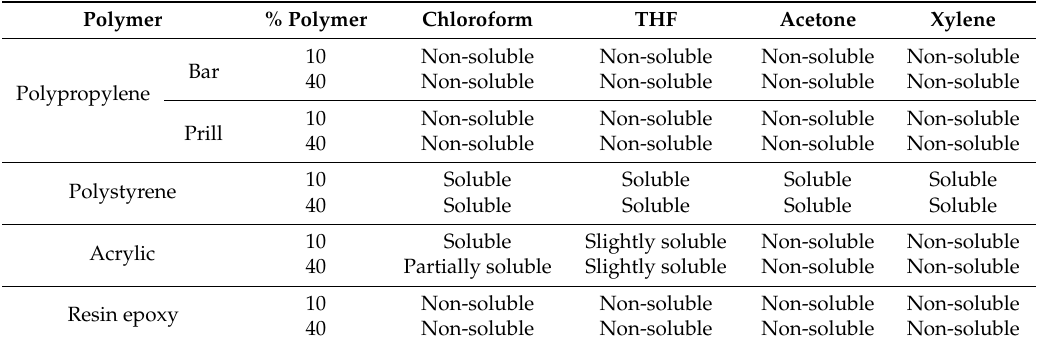
Table 1. Solubility of polymers into